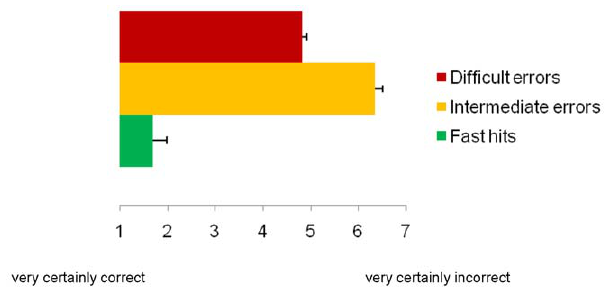
Figure 2. Subjective ratings. Results of the control behavioural study show that participants were on average less certain of errors in the difficult than in the intermediate condition. Interestingly, ratings in the difficult condition suggest a bias towards the (right-end) error side, as if participants somehow ‘‘felt’’ they had committed an error in this condition. Importantly, participants were also quite certain of their correct responses on Go trials. Horizontal bars represent the S.E.M.